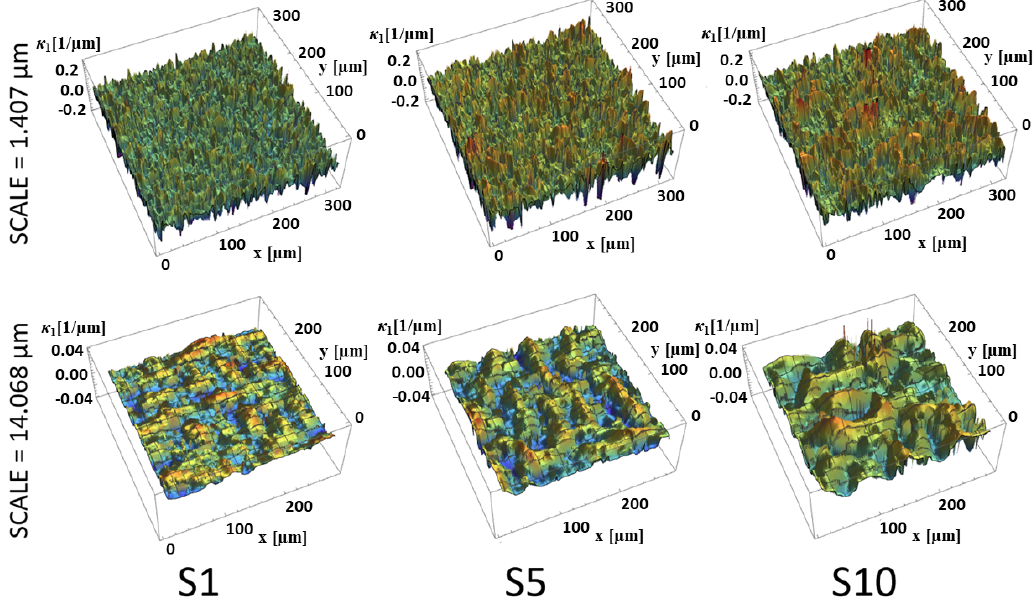
Figure 9. Maximum curvature κ 1 for representative measurements of surfaces: S1, S5 and S10, calculated for two different scales: s = 1.407 and s = 14.068 µm. Please note that vertical scale ( z -axis) for upper row is fivefold greater than for the lower row.